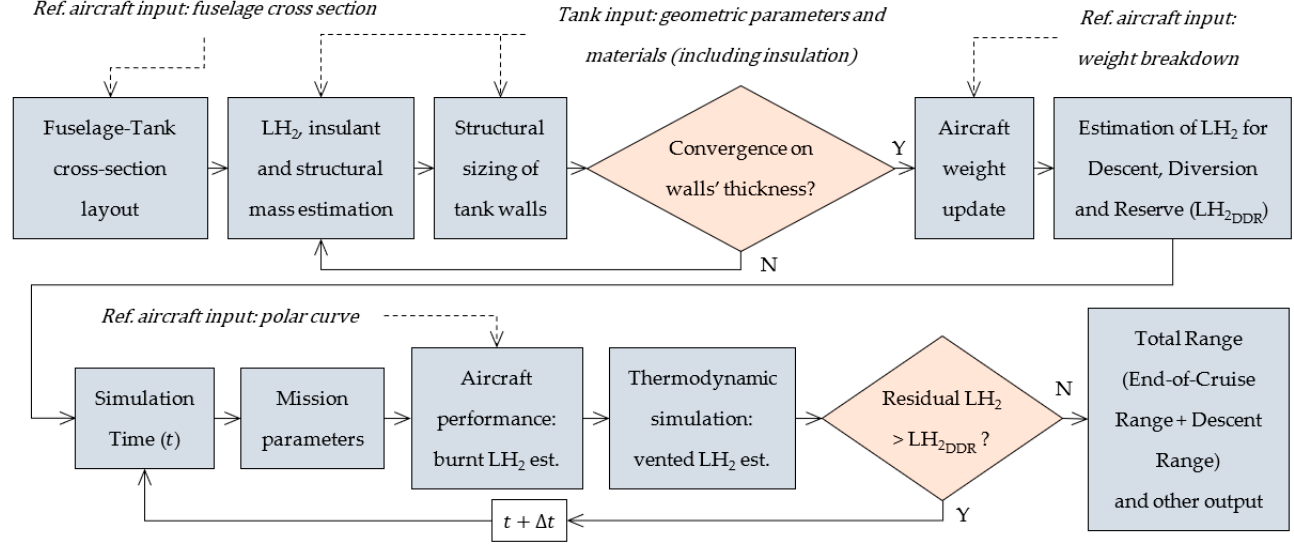
Figure 6. Scheme of the analysis method workflow.